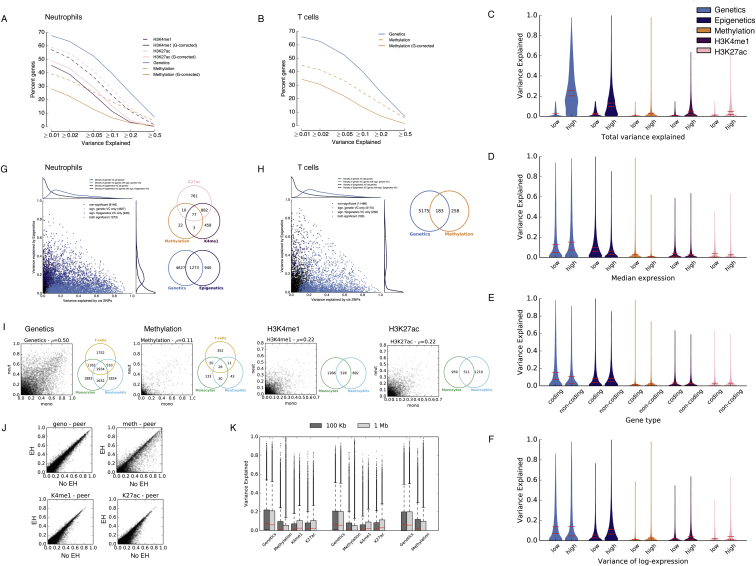
Variance Decomposition Analyses, Related to Figure 2(A and B) Figures showing analogous results as those presented in Figure 2B; however, for neutrophils and naive CD4+ T cells.(C–F) Variance partitioning results obtained from the joint model across all four molecular layers in monocytes. Shown are the distributions of variance explained by genetics, cumulative epigenetics as well as separately for individual epigenetic layers for different sets of genes. Specifically, genes were stratified by the median of (C) the total variance explained by the joint model (“low” and “high” indicate genes below and above the median), (D) the median gene-expression level, (E) gene type and (F) the variance of the log of the expression levels.(G and H) Figures showing analogous results as those presented in Figures 2C–2E; however for neutrophils and naive CD4+ T cells.(I) Pairwise correlation of the variance explained by different molecular layers between monocytes and neutrophils. Epigenetic contributions were estimated using a model that accounts for underlying genetic variation (see the STAR Methods). The Spearman’s rank correlation (ρ) is also reported. Venn Diagrams show the overlap of genes with significant genetic, methylation, H3K4me1 and H3K27ac contributions between monocytes and neutrophils (FDR < 5%, using a variance component test, see the STAR Methods).(J) Comparison of variance component estimates for individual molecular layers either considering a model that accounts for expression heterogeneity (EH, y axis) or a model that does not account for EH (no EH, x axis) in monocytes (see the STAR Methods). The genetic variance estimates were consistent across both approaches, whereas epigenetic variance estimates were substantially increased when not using the additional EH adjustment.(K) Comparison of the proportion of variance explained by different molecular layers across cell types when either considering a 100Kb or a 1Mb cis window (see the STAR Methods).